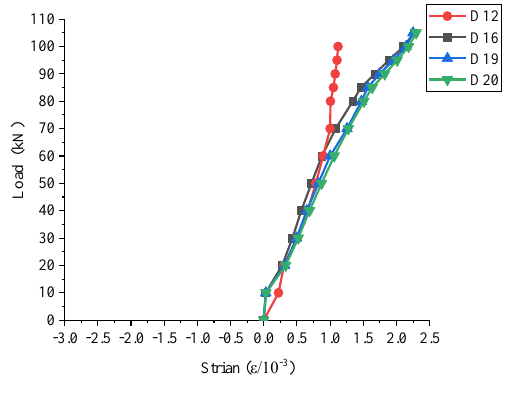
Figure 20. Load–strain curve of S1, area D. Appl. Sci. 2019 , 9 , x FOR PEER REVIEW